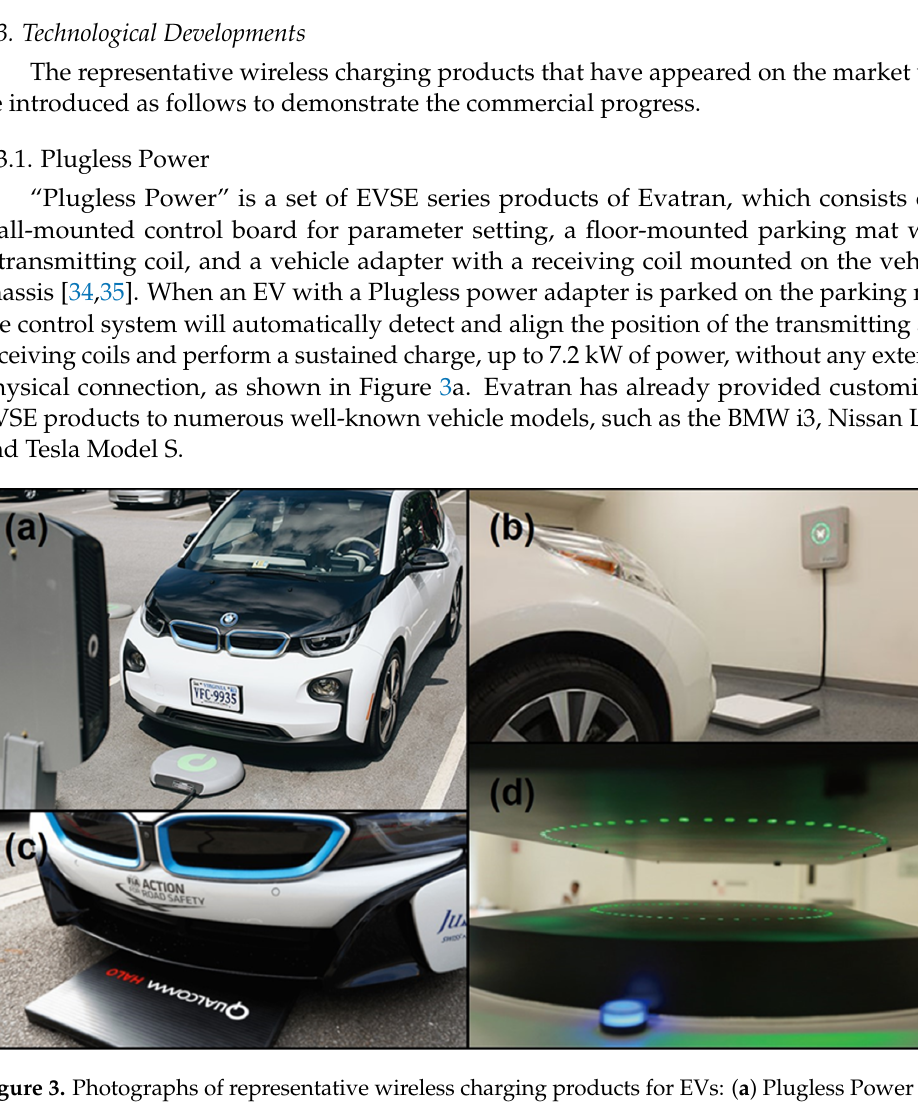
Figure 3. Photographs of representative wireless charging products for EVs: ( a ) Plugless Power [36]; ( b ) WiTricity [37]; ( c ) Qualcomm Halo™ [38]; ( d ) Wireless charging system developed by APAS and